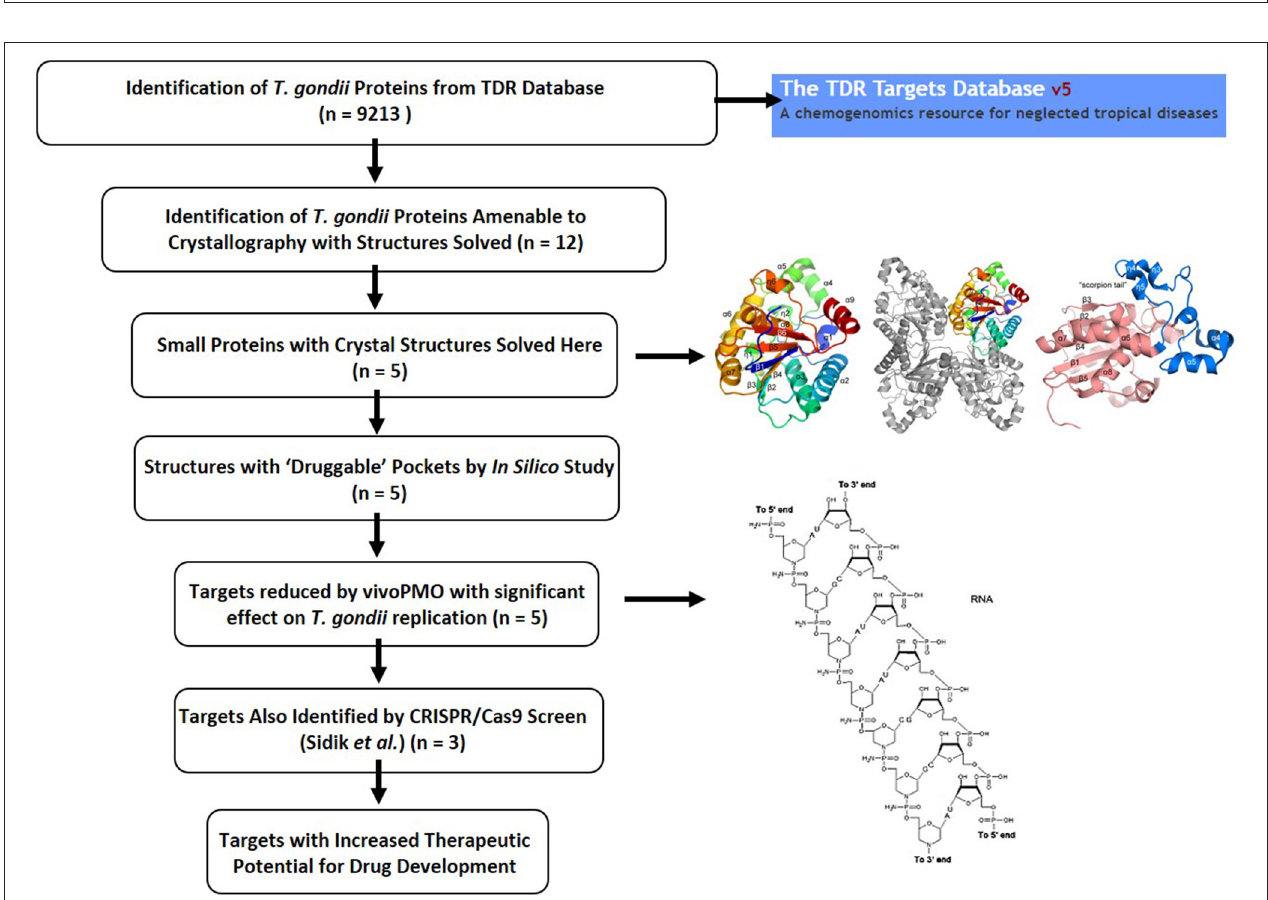
FIGURE 9 | Immunofluorescence Assay. This series of images depict the localization of nucleoside diphosphate kinase, one of the molecular targets herein discussed. Note the concentration of red fluorescence at the periphery of the parasite. This is consistent with the localization of secreted proteins like Gra1, suggesting that NDK could be secreted by the parasite. This has precedents in other pathogens, including M. tuberculosis and Leishmania .